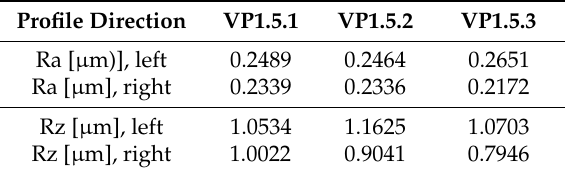
Table 5. Achieved surface roughness values on soft machining for test blanks VP1.5.1 to VP1.5.3.